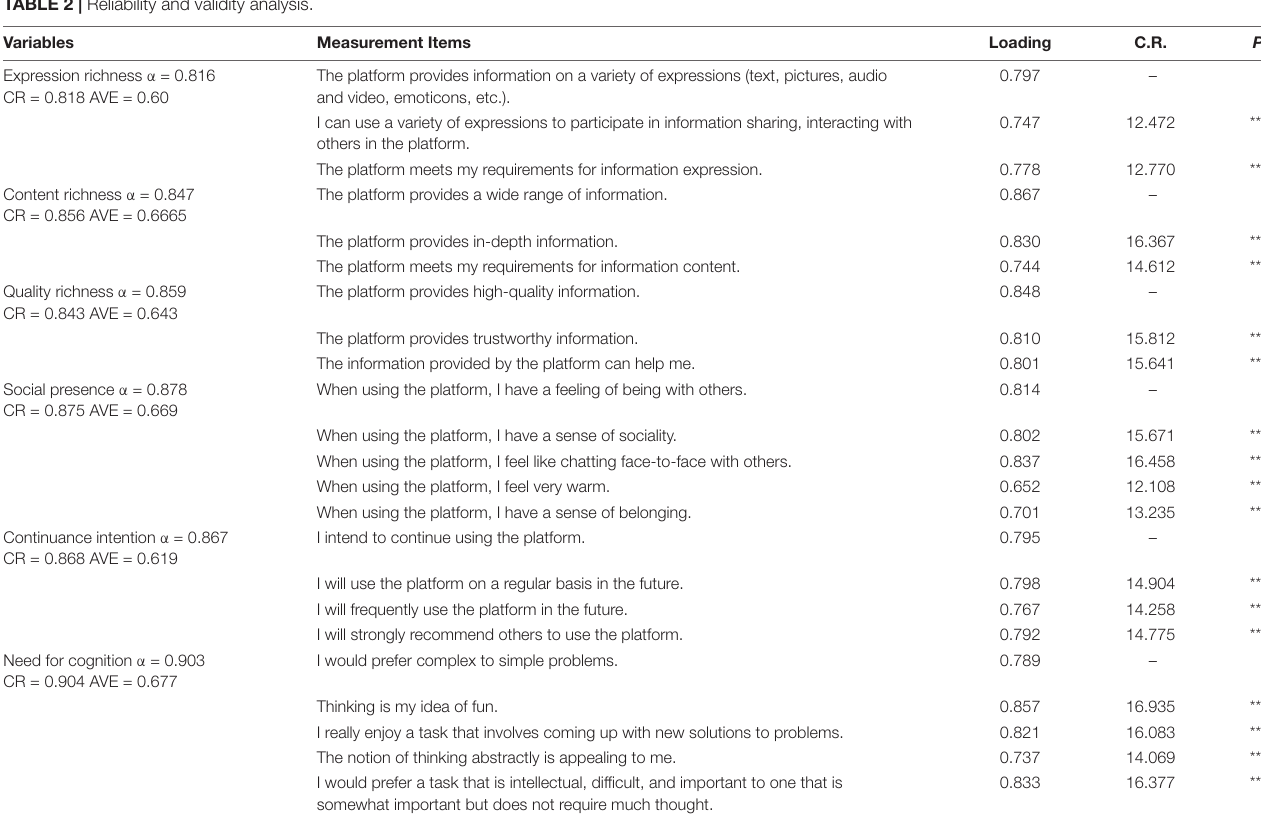
TABLE 2 | Reliability and validity analysis. Variables Measurement